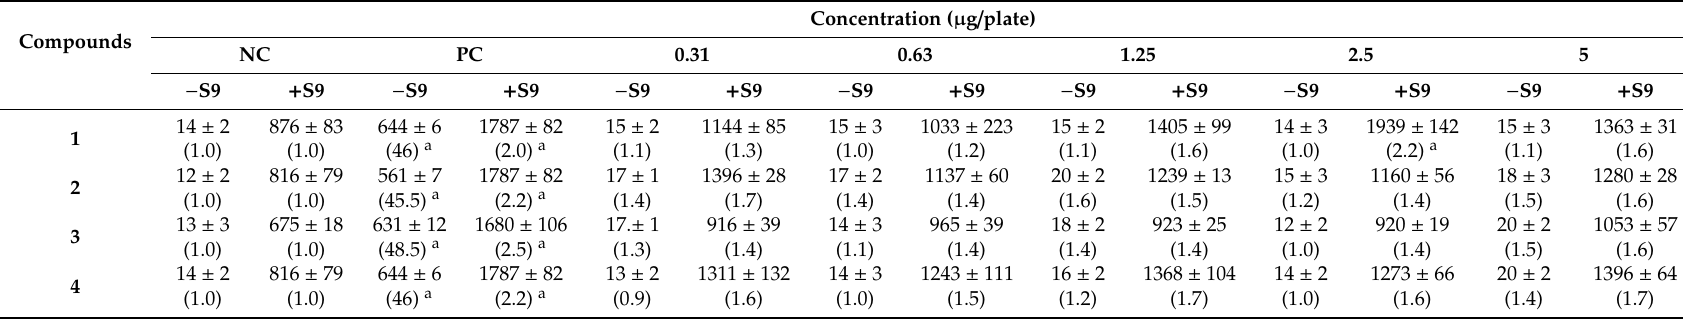
Table 2. The number of revertant colonies of TA98 strain of Salmonella typhimurium in the absence ( − S9) and presence ( + S9) of metabolic activation system. Compounds